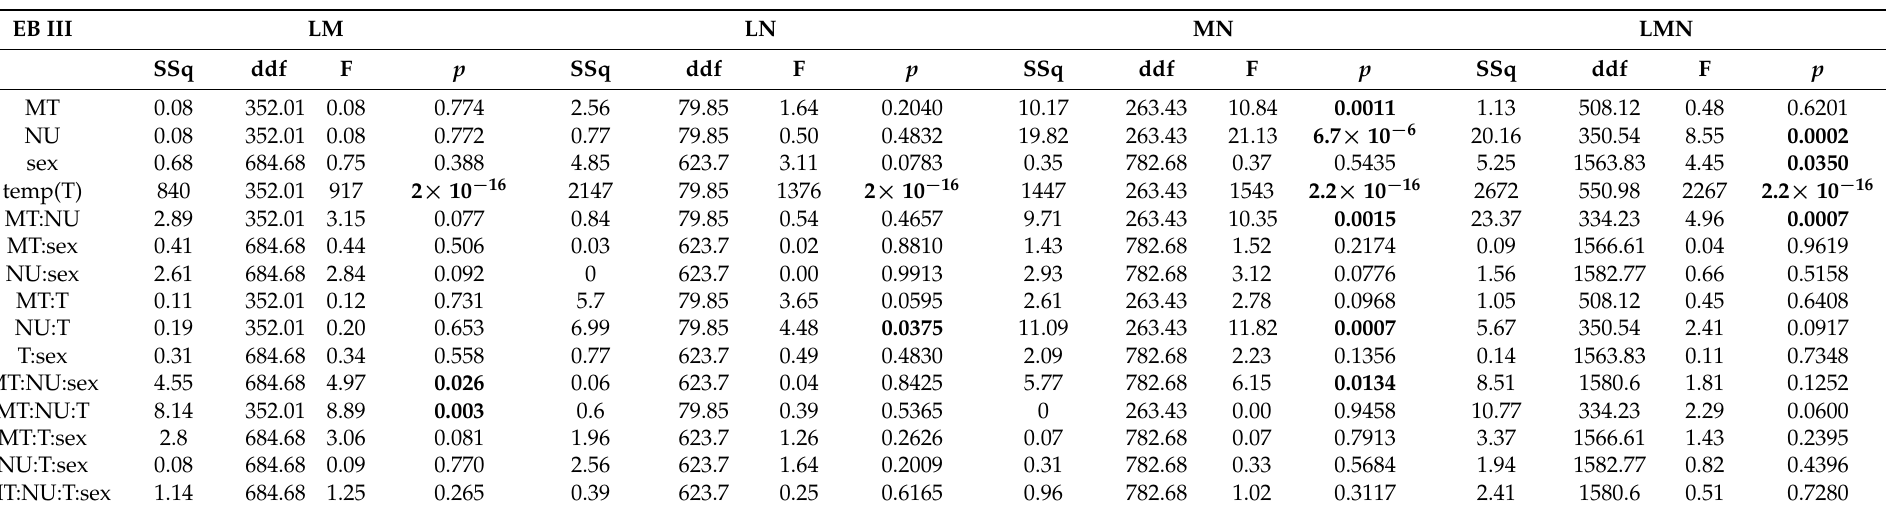
Table 8. The effect of mitochondrial haplotype (MT), nuclear genetic background (NU), sex, temperature (T) and their interactions on developmental time for the three pairwise comparisons from experimental block (EB) III and the whole EB III of D. obscura . SSq, sum of squares; ddf, denominator degrees of freedom; p values that are significant at p < 0.05 are given in